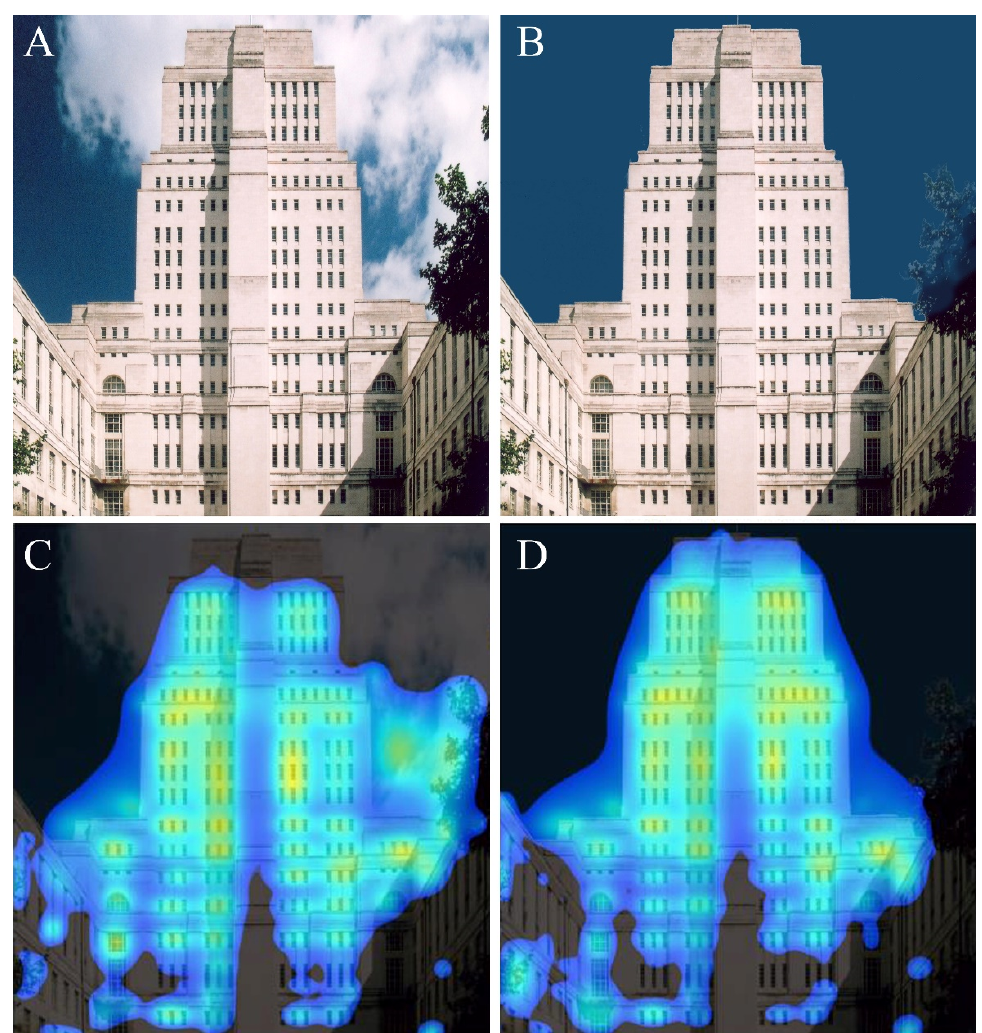
Figure 15. A photograph of the London University Senate House from the 1930s in its original form ( A ), with eye-tracking simulation heatmap ( C ). After removing the clouds from the photo ( B ), the new heatmap provides more accurate architectural information ( D ).